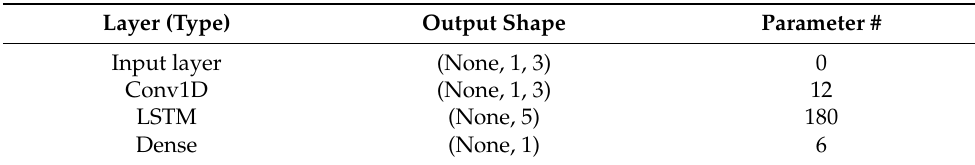
Table 2. Structural parameters of